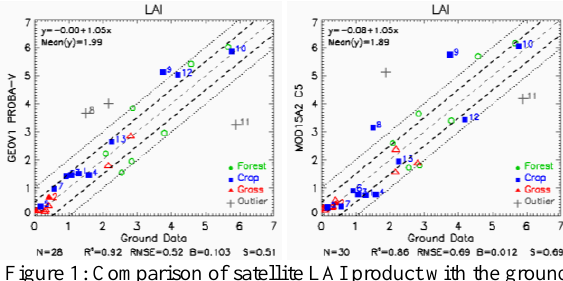
Figure 1: Comparison of satellite LAI product with the ground- based maps. Left side: PROBA-V GEOV1. Right side: MODIS C5. Filled symbols correspond to concomitant values of 2014 from ImagineS project and unfilled symbols to a different